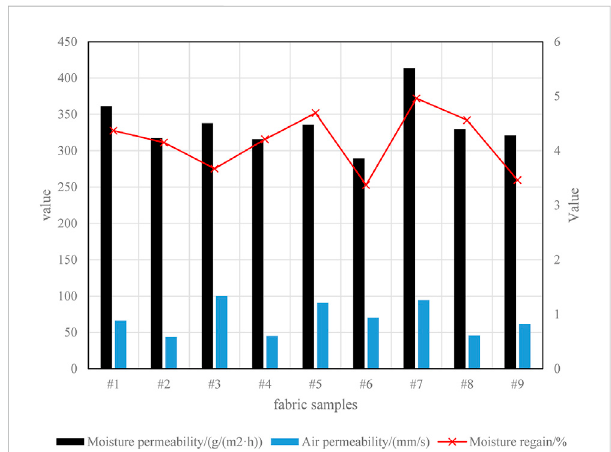
FIGURE 7 Experimental results of water permeability, air permeability and moisture absorption of fabrics.